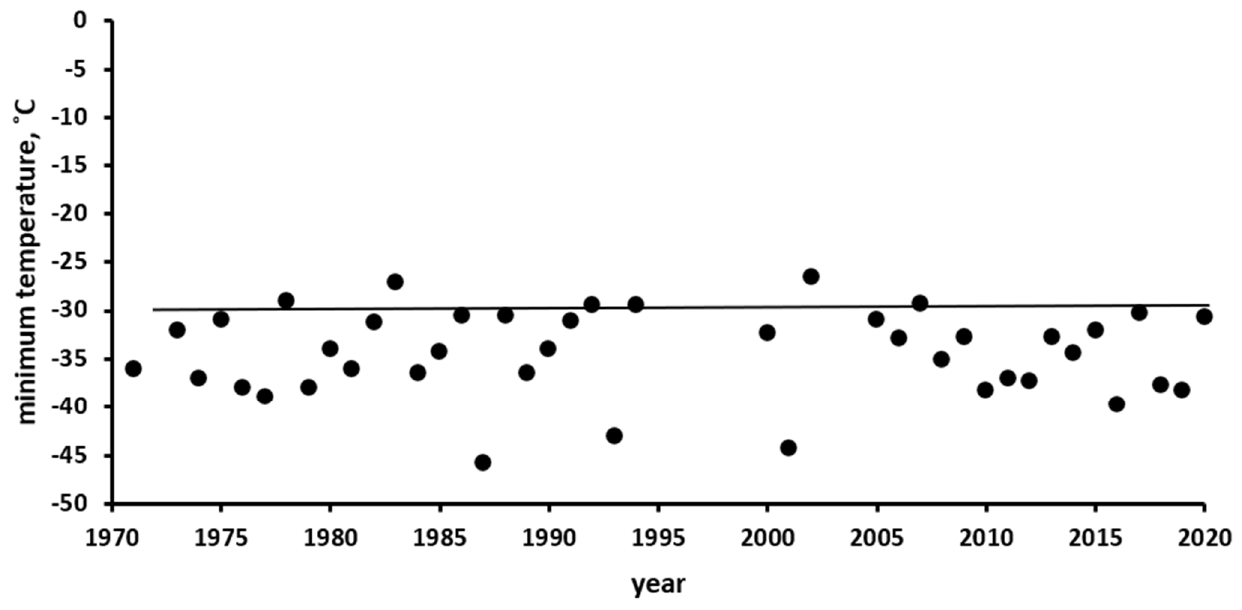
Figure 3. Minimum air temperatures by year, according to the weather station in Ust’-Kan (50.93 ◦ N, 84.75 ◦ E, 1037 m above sea level) (http://www.pogodaiklimat.ru/history/36213.htm, accessed on 1 January 2021). The solid line corresponds to the critical negative temperature that is lethal to the eggs of the Altai SM